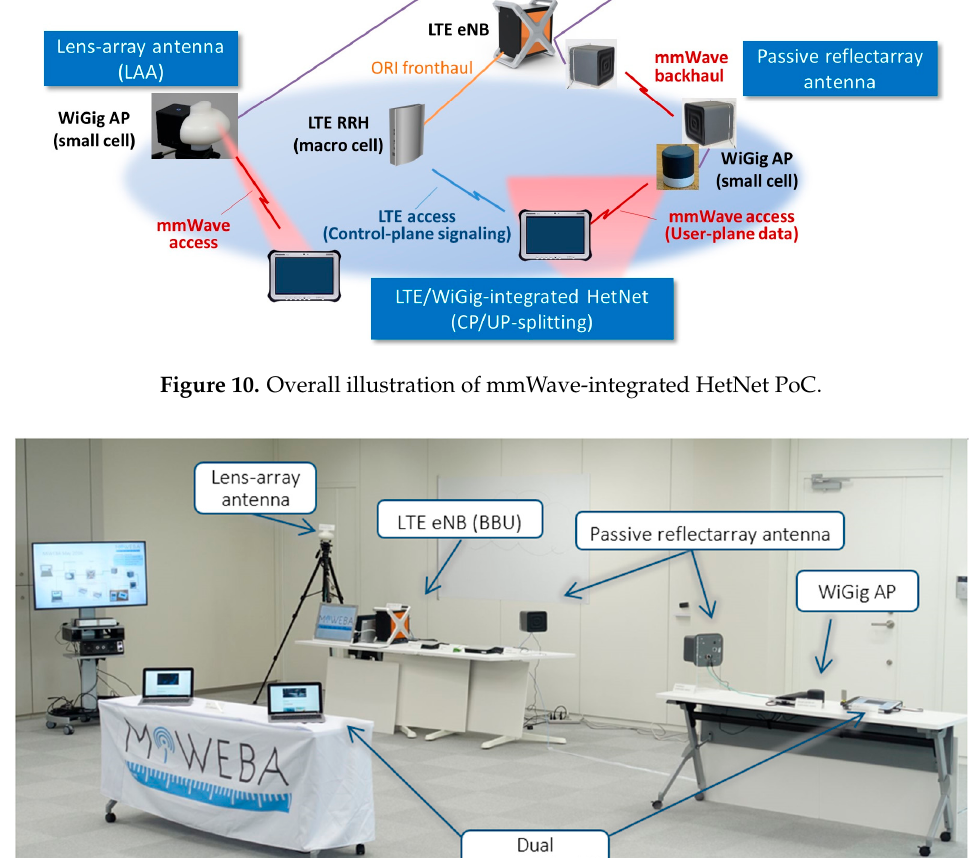
Figure 12. PoC for LTE-WiGig-integrated HetNet: ( a ) LTE eNB, RRH and WiGig AP and ( b ) dual-connectivity UE with LTE and WiGig modules. Figure 13 shows the protocol stack of the PoC. This was similar to LWIP, but with the security protections omitted for simplicity. Security is an important feature of mobile networks, but was not the focus of the current PoC. We will return to this feature in future work. An LTE-WiGig-integrated CP (multi-RAT CP) application was implemented on top of the CP protocol stack. The multi-RAT CP monitored the real-time traffic load and radio link conditions, such as the received signal-strength indicator (RSSI) of both the LTE and WiGig. The measured link condition on UE was reported to the eNB by CP signaling via LTE. On the basis of the monitored information, the multi-RAT CP on the eNB managed the handling of the UP data. The UP data path was switched between LTE and WiGig by Open vSwitch (OVS) [68]. When the WiGig was used, the multi-RAT CP controlled activation and authentication of the WiGig. PDCP SDUs were sent via the WiGig or LTE link. Since the interface between the LTE-eNB and WiGig-AP was IP-based, various Layer-2 media can be used for the